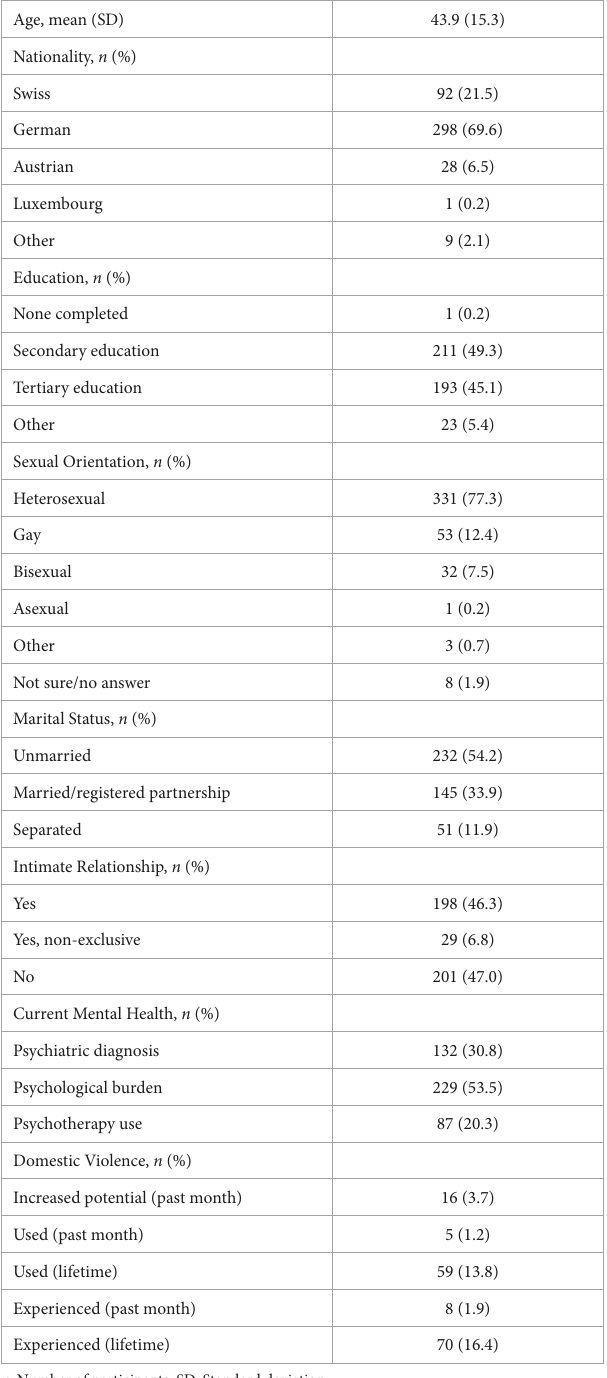
TABLE 1 Descriptive statistics of the sample ( n =